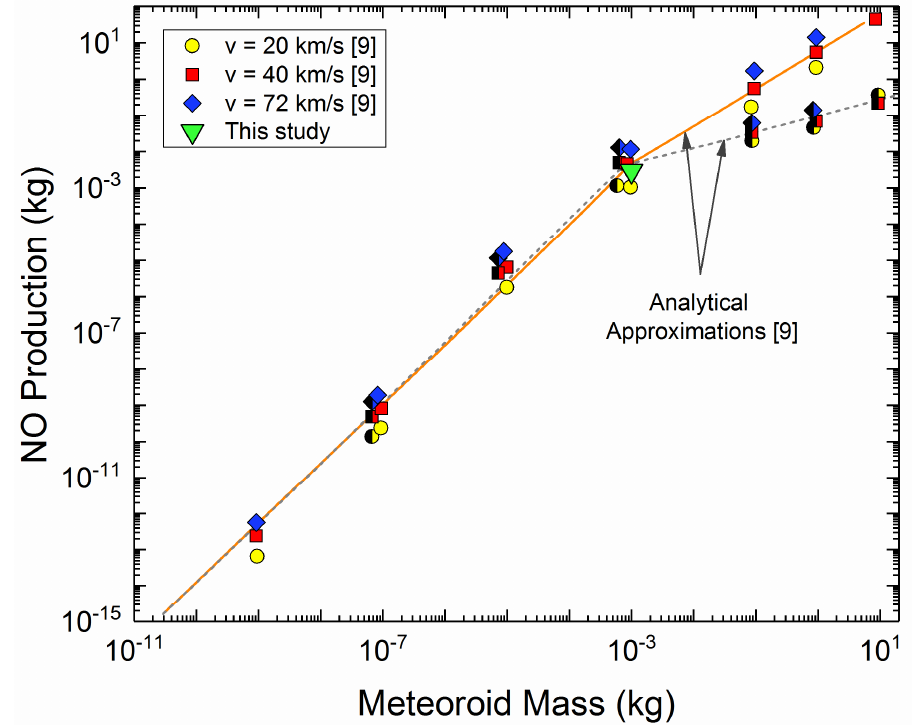
Figure 1. The comparison of the estimated NO production for a single event (green triangle) with the numerically derived results [9] for a range of impact velocities. Since there is no appreciable difference in the results for vertical and oblique impacts as demonstrated by Menees and Park [9], we only show the points from their study that correspond to vertical impacts. Half-filled points represent the diffusion boundary and open points represent the shock boundary.